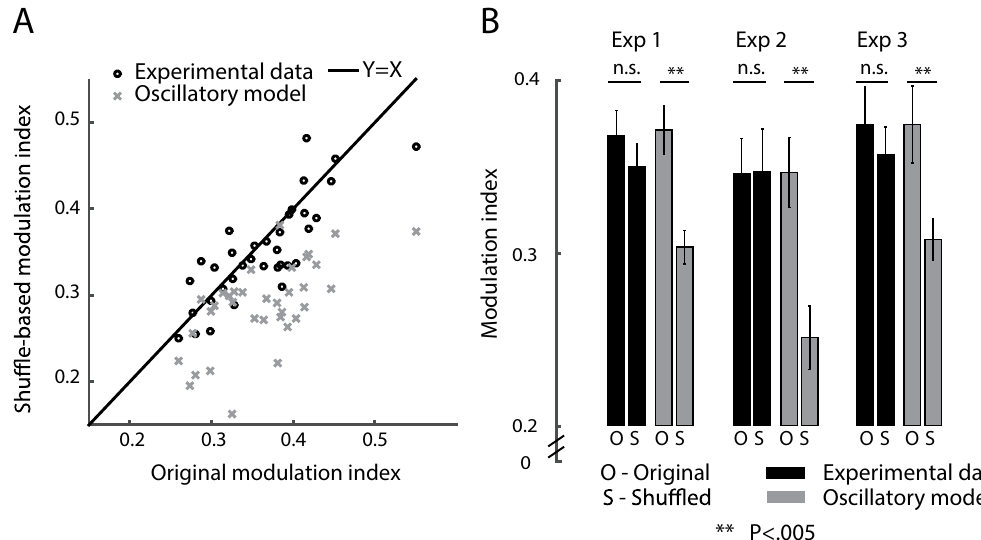
Figure 8. Modulation indices of individual subjects and groups (surrogate blink-free data). This figure is equivalent to Fig. 7 remade using blink-free saccade sequences. ( A ) For each subject, the shuffled sequence modulation index is plotted as a function of real modulation index (black circles). As a baseline for this analysis, the shuffled oscillatory sequence modulation index is plotted as a function of the original modulation index (gray Xs). ( B ) For each experiment, the mean modulation index before and after shuffling is given, both for real data (black) and oscillatory model (Gray). Data are represented as mean ± SEM, N = 12,11,12 for Exp 1–3